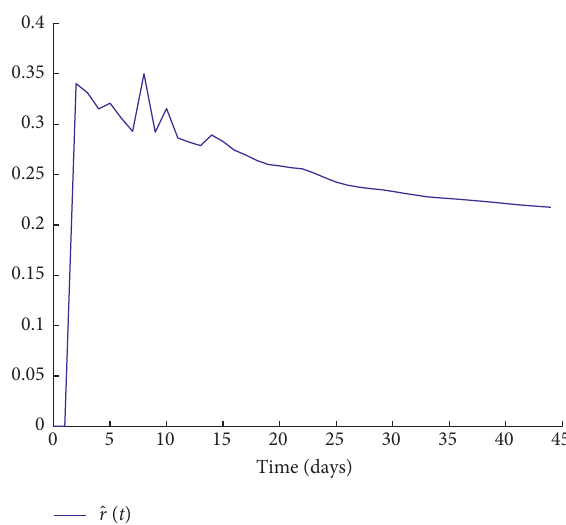
Figure 13: Estimation of the carrying capacity from filtered re- ported data (Italy).